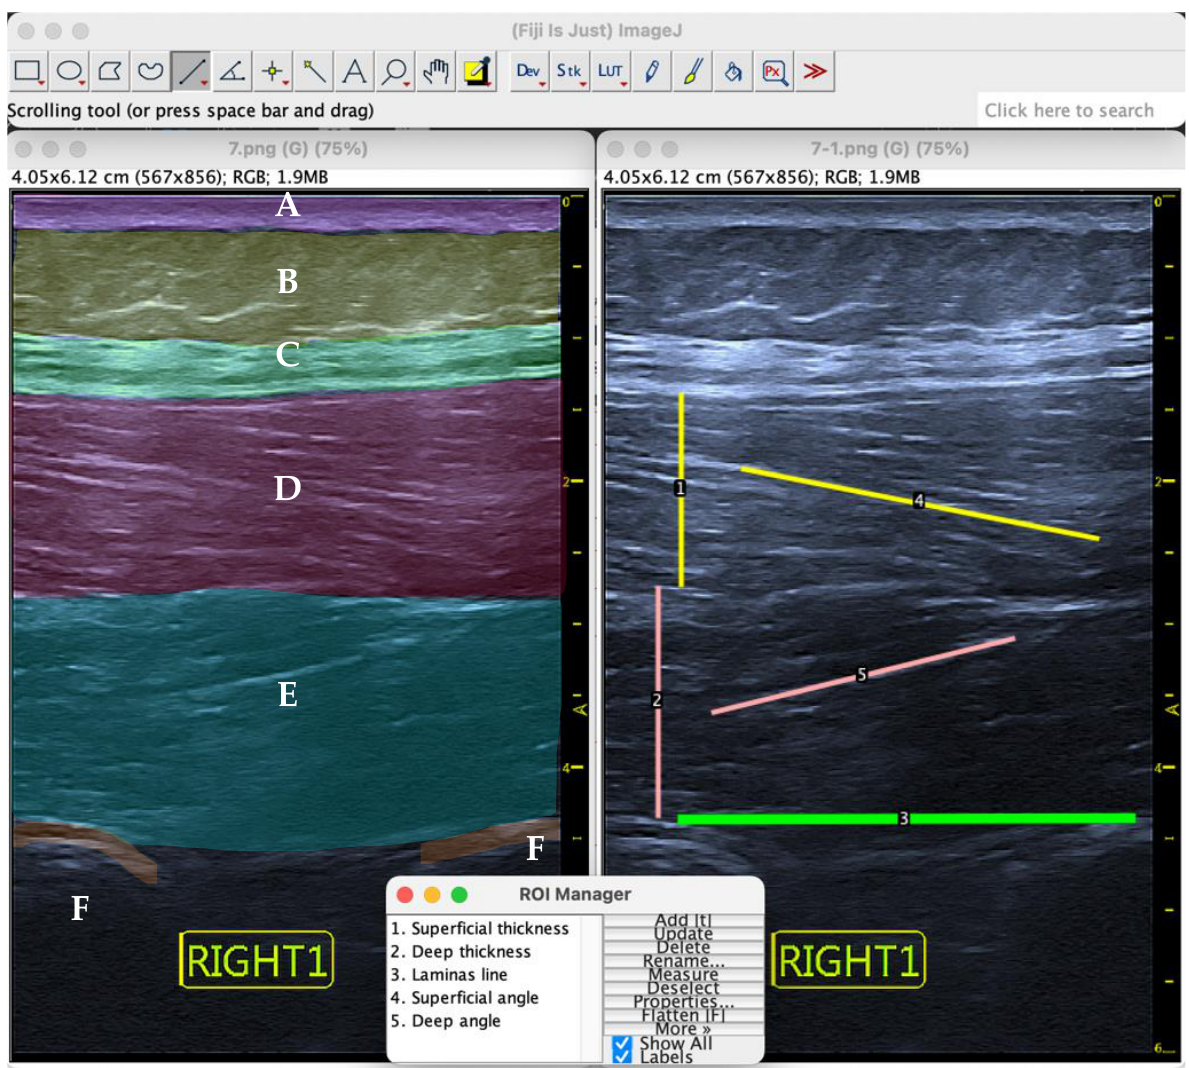
Figure 2. Ultrasound image of the lumbar multifidus musculature (sagittal view) during measure- ment of the thickness (lines 1–2) and pennation angle (lines 4–5). ( A ) Skin; ( B ) fat; ( C ) thoraco-lumbar fascia; ( D ) superficial multifidus; ( E ) deep multifidus; ( F ) laminae.